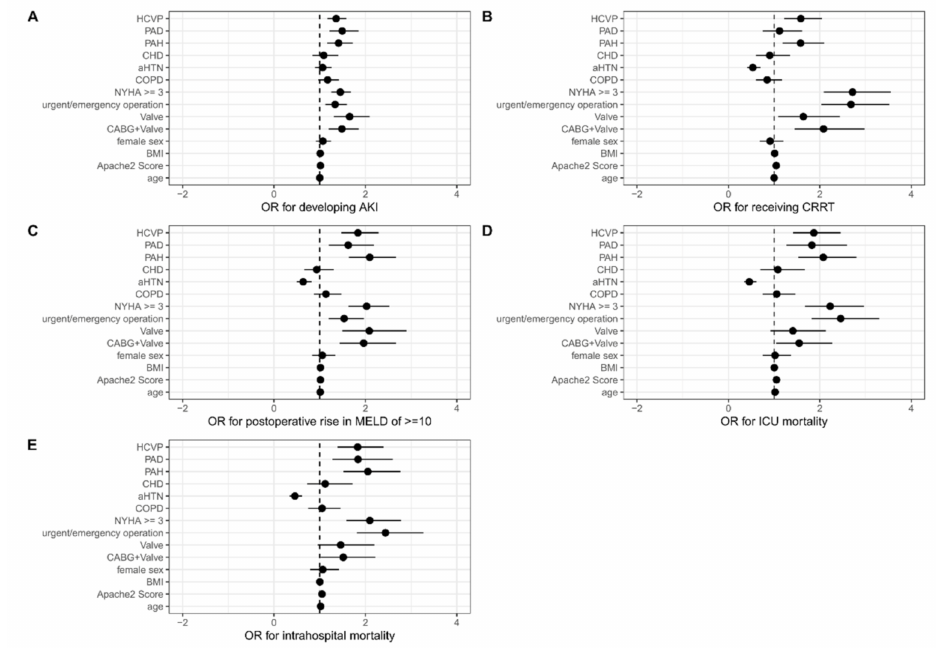
Figure 4. Odds ratio for different outcome parameters. Abbreviations: HCVP: high central venous pressure, i.e., median initial CVP > 11 mmHg; PAD: peripheral arterial disease; PAH: pulmonary arterial hypertension; CHD: coronary heart disease; aHTN: arterial hypertension; COPD: chronic obstructive pulmonary